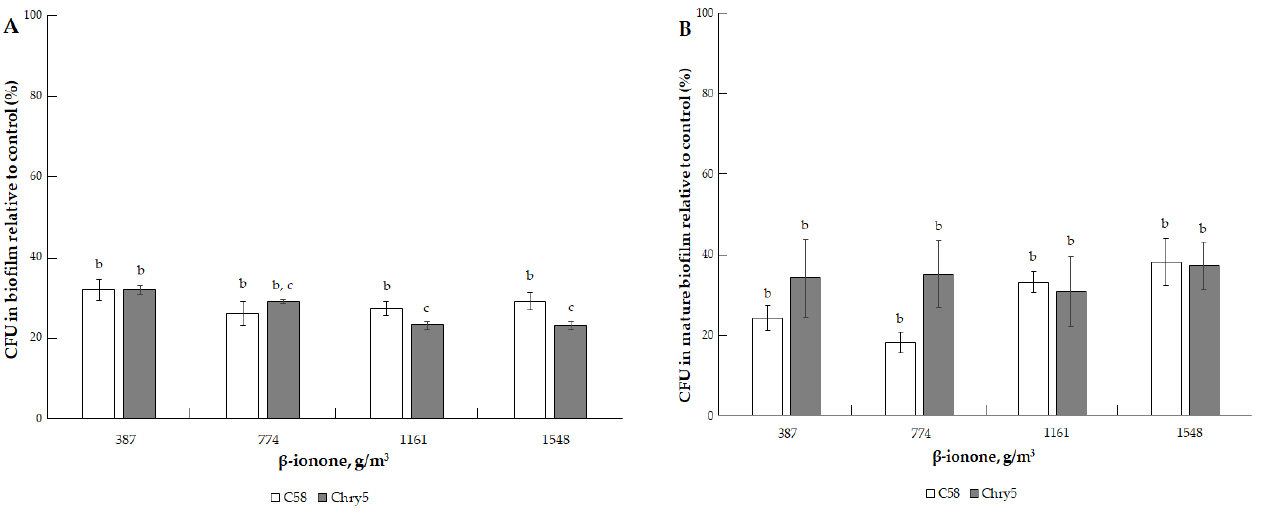
Figure 4. The effect of 2-butanone on the formation of biofilm of A. tumefaciens C58 (white column) and Chry5 (gray column) ( A ) and cell survival in mature biofilms ( B ) depending on the concentration of 2-butanone. CFU of bacteria strains in the control (without VOC): 100 a %. The different lowercase letters above the mean values indicate significant differences ( p ≤ 0.05; Tukey’s HSD test).